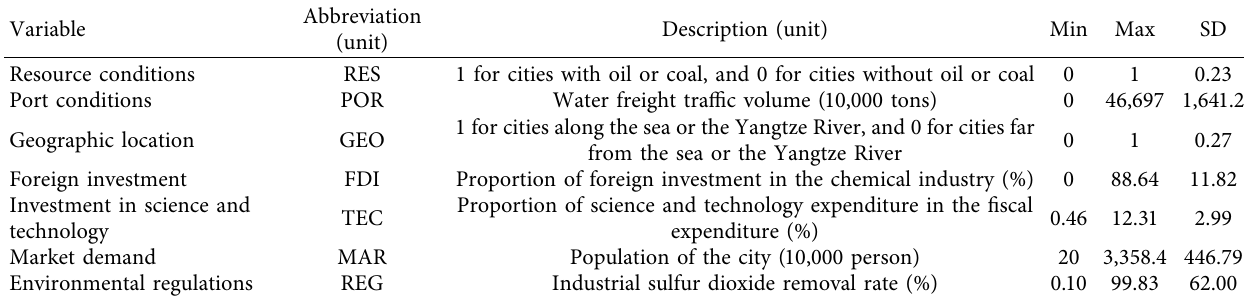
Table 1: Definitions and descriptions of variables and their 2013